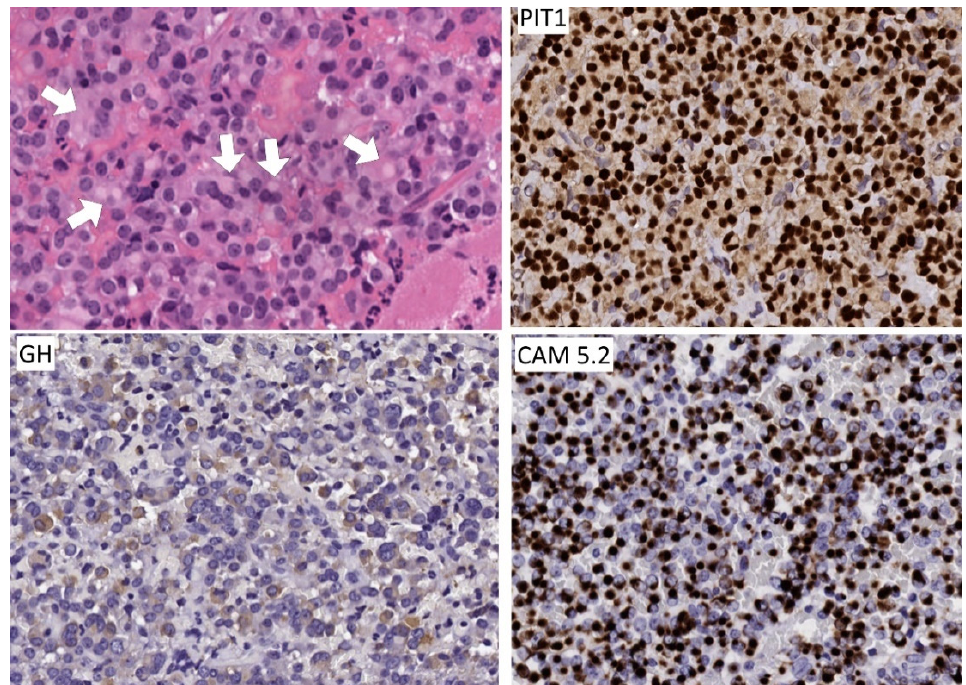
Figure 3. Morphology of sparsely granulated somatotroph tumor. The tumor cells are discohesive and pleomorphic with prominent cytoplasmic pale globules seen on H&E ( top left , arrows). The tumor cell nuclei are intensely positive for PIT1 that highlights their pleomorphism. Staining for GH is weak and focal and can be easily missed. The keratin stain identifies the highly characteristic fibrous bodies that are found in the vast majority of tumor cells and are the hallmark of this tumor type.